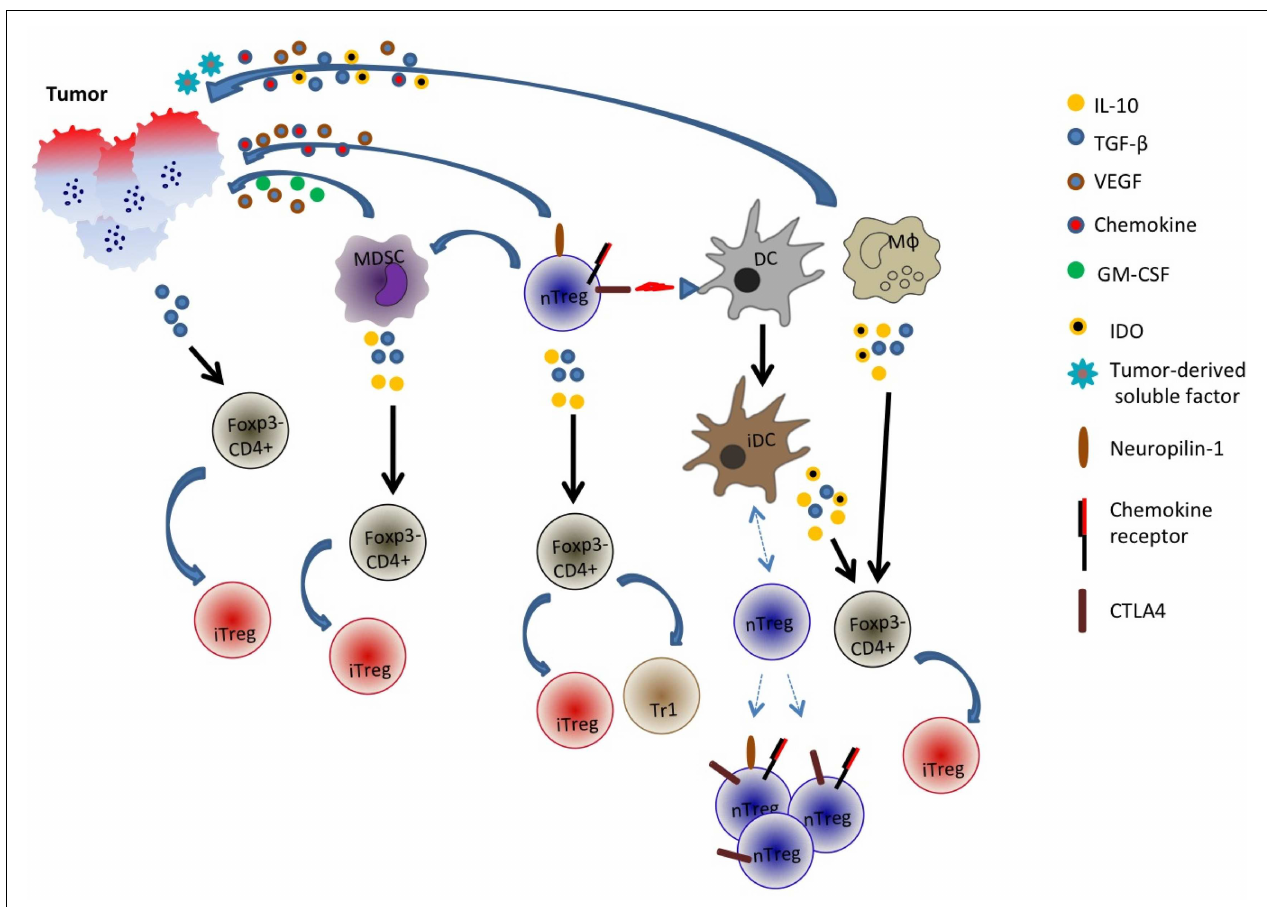
immune-suppressive factors such asTGF- β , IL-10, and indoleamine 2,3-dioxygenase (IDO) that could potentially convert some Foxp3 − CD4 + cells into Foxp3 + cells. Additionally, tumor-derived factors orTreg interaction with DCs may promote generation of tolerogenic or immature DC (iDC) that recruit distinct populations of naturalTregs. nTreg is CD4 + Foxp3 + cells while iTreg is CD4 + Foxp3